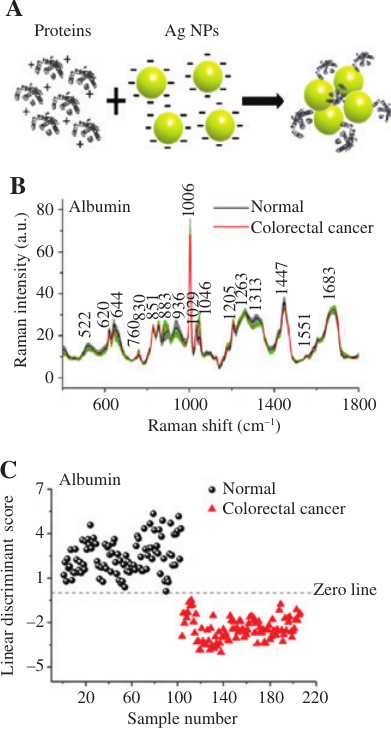
Figure 2: (A) Schematic of a label-free assay utilizing silver colloidal nanoparticles for the detection of proteins via electrostatic aggrega- tion of Ag NPs in the presence of the protein. (B) Example of Raman spectrum of serum albumin using label-free colloidal SERS in the detection of colorectal cancer. (C) Scatter plot of the linear discrimi- nant scores belonging to the normal and colorectal cancer group, calculated from the datasets of albumin. Reprinted with copyright permission from [144], Copyright 2014 Journal of Photonics